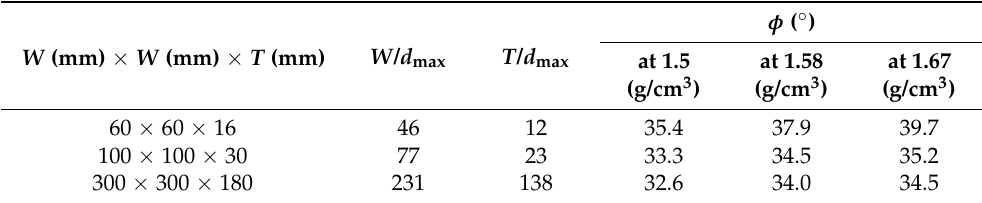
Table 6. Friction angles of sand at three different densities, obtained by direct shear tests with three different size shear boxes